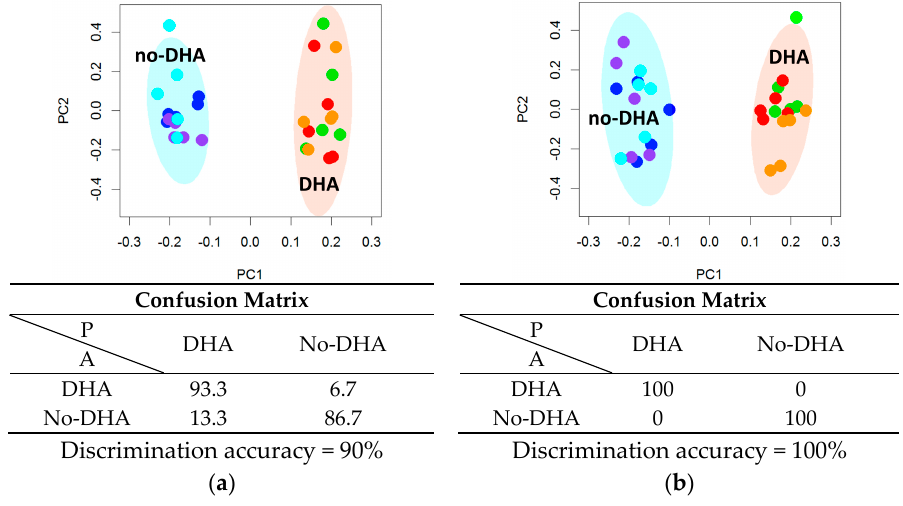
Figure 1. Lipidomic phenotyping by nuclear magnetic resonance (NMR) analysis of cells not supplemented and supplemented with docosahexaenoic acid (DHA), alone or in combination with protocatechuic acid (PCA) or propionic acid (PRO), for ( a ) 6 h and ( b ) 24 h. Principal component analysis and canonical analysis (PCA-CA) score plots: PC1 vs. PC2. In each group, five samples derived from three independent experiments were analyzed. Each symbol represents a different sample. Blue symbols = NS; purple symbols = PCA; cyan symbols = PRO; orange symbols = DHA; green symbols = DHA + PCA; red symbols = DHA + PRO. For each PCA-CA model, the confusion matrix and the discrimination accuracy are reported; A: actual classes; P: predicted classes.